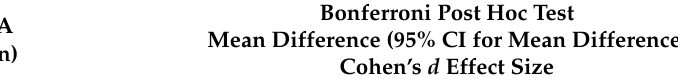
Table 2. Within-person ANOVA with Bonferroni post hoc